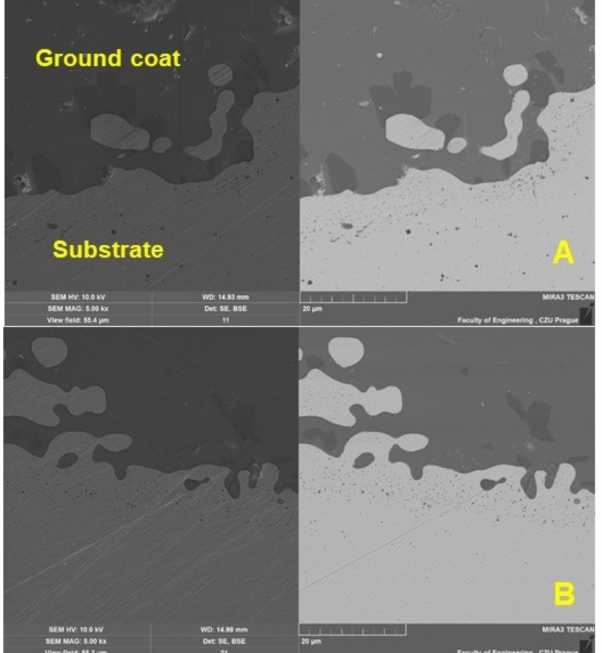
Figure 7. SEM analysis of a cross-section of a test specimen before wear—a detailed view of the interaction between the metal material (substrate) interface and the base enamel surface fused to the metal surface (SE detector Oxford—left, BSE detector Oxford—right): ( A ): original enamel (MAG 5.0k × ), ( B ): renovated enamel applied by local heating (MAG 5.0k × ).